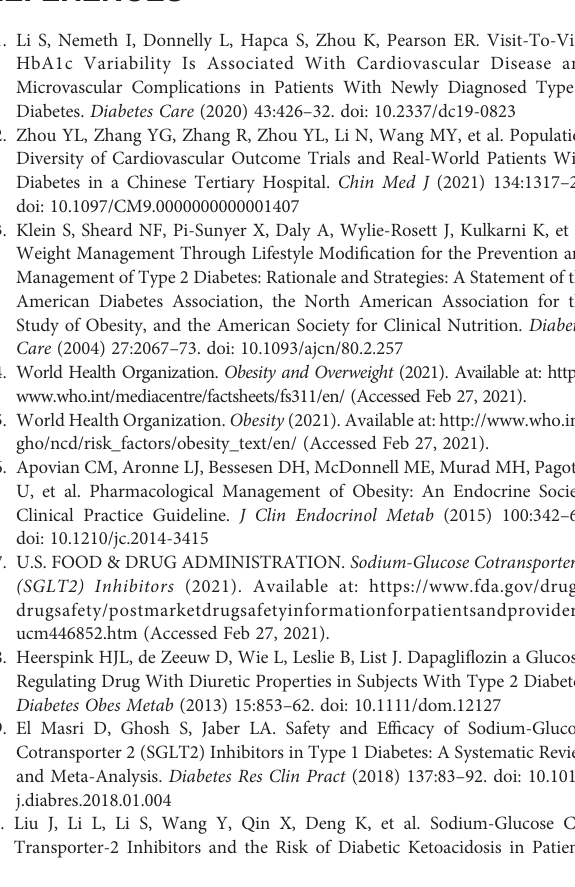
Supplementary Figure 2 | Risk of bias summary of all included studies (n=6). Supplementary Figure 3 | Trial sequential analysis of body weight change. RIS, Required information size. Supplementary Figure 4 | Trial sequential analysis of BMI change. RIS, Required information size; BMI, Body mass index. Supplementary Information 1 | Medline Searching strategy.